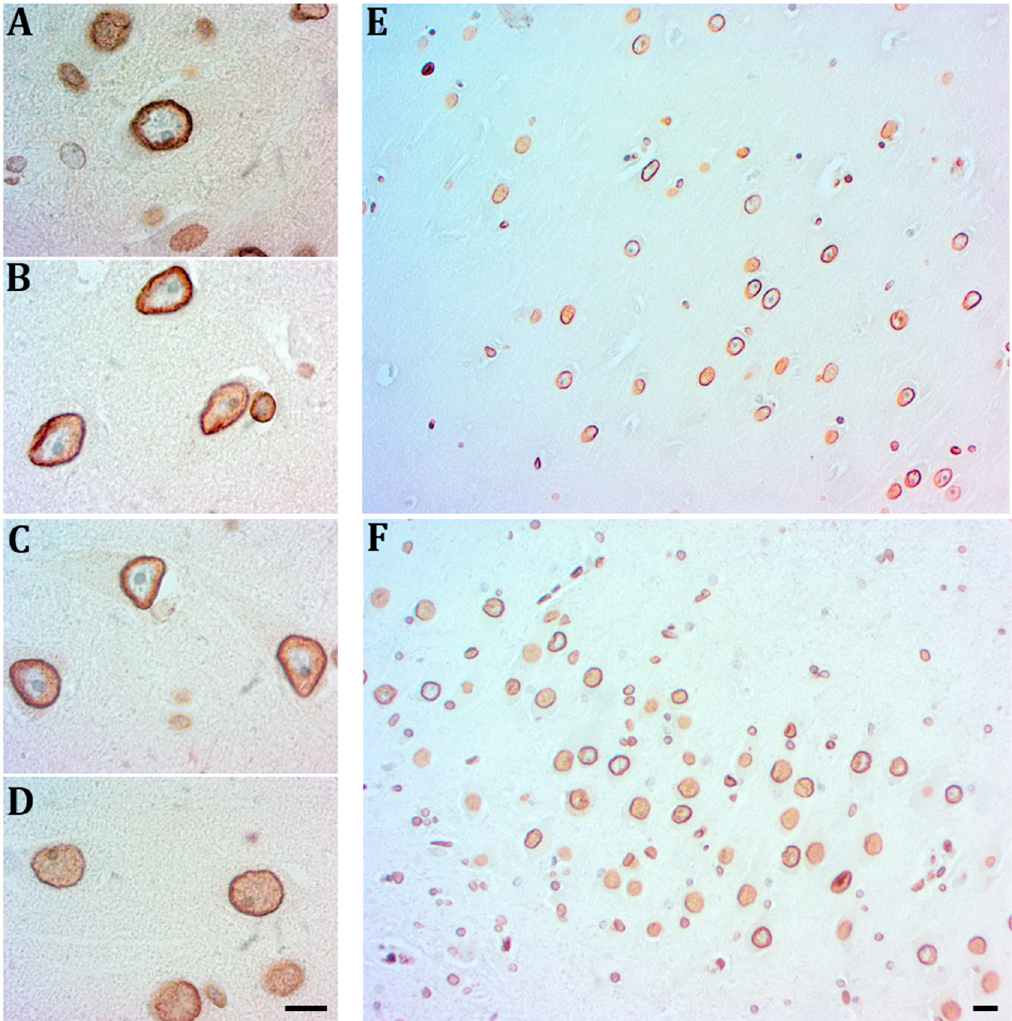
Figure 7. Relationship of Lamin B2 with Lamin A at early AD stages. Lamin B2 immunopositivity (DAB-brown) covers the nucleoplasm of neurons with nucleoli displaced to the periphery or without nucleoli and signs of degeneration ( A , D ). A reinforced Lamin B2 associated with Lamin A (red- amino-ethyl-carbazole) characterizes neurons with euchromatic nuclei with prominent nucleoli ( B , C ). In the hippocampus at AD I-II stages the two neuron populations coexist in CA1 ( E ) and CA3 ( F ), scale bar—5 µm.